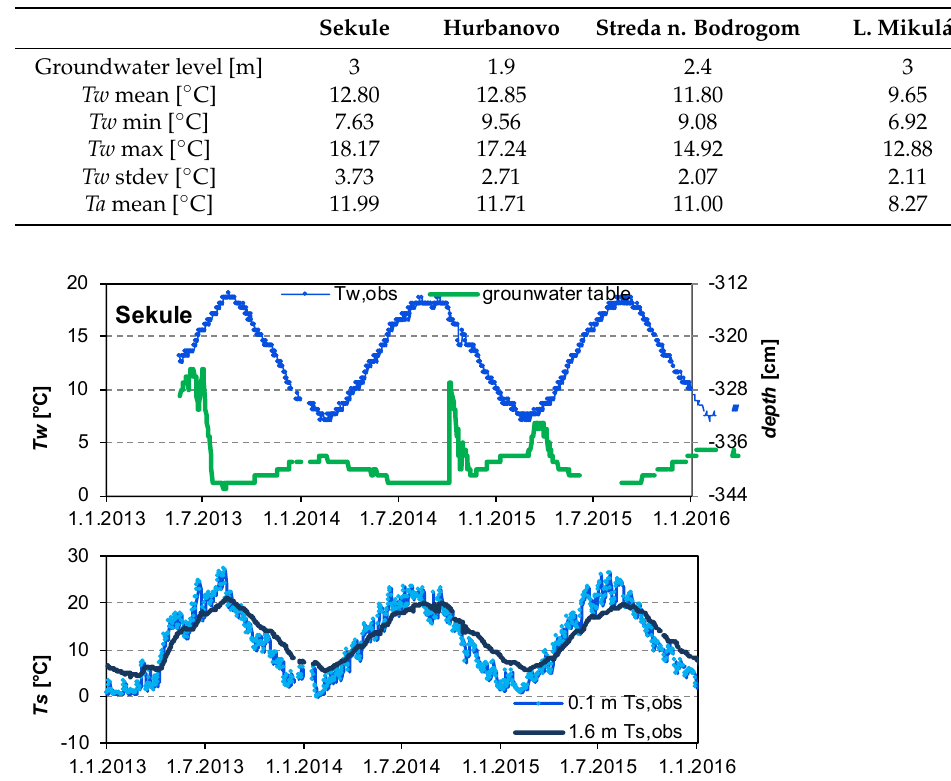
Table 3. Baseline characteristics of groundwater temperature ( Tw ) at four selected stations for the period 1.1.2013–31.12.2016.